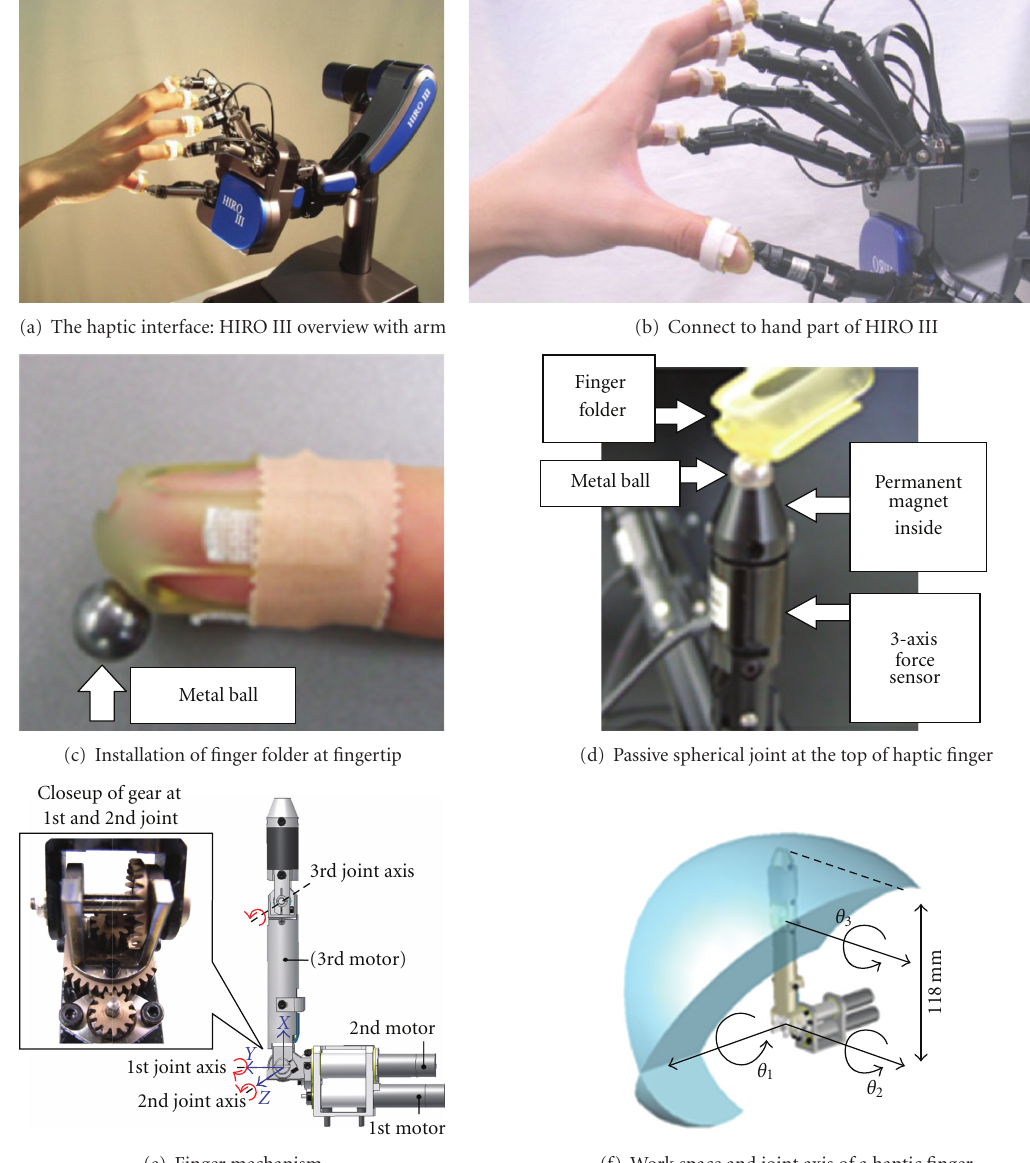
Figure 2: The system of the multifingered haptic interface robot: HIRO III. This robot has five haptic fingers, and the fingers have 3 degree of freedom and a 3-axis force sensor. In (f) the blue volume shows the movable work space of the haptic